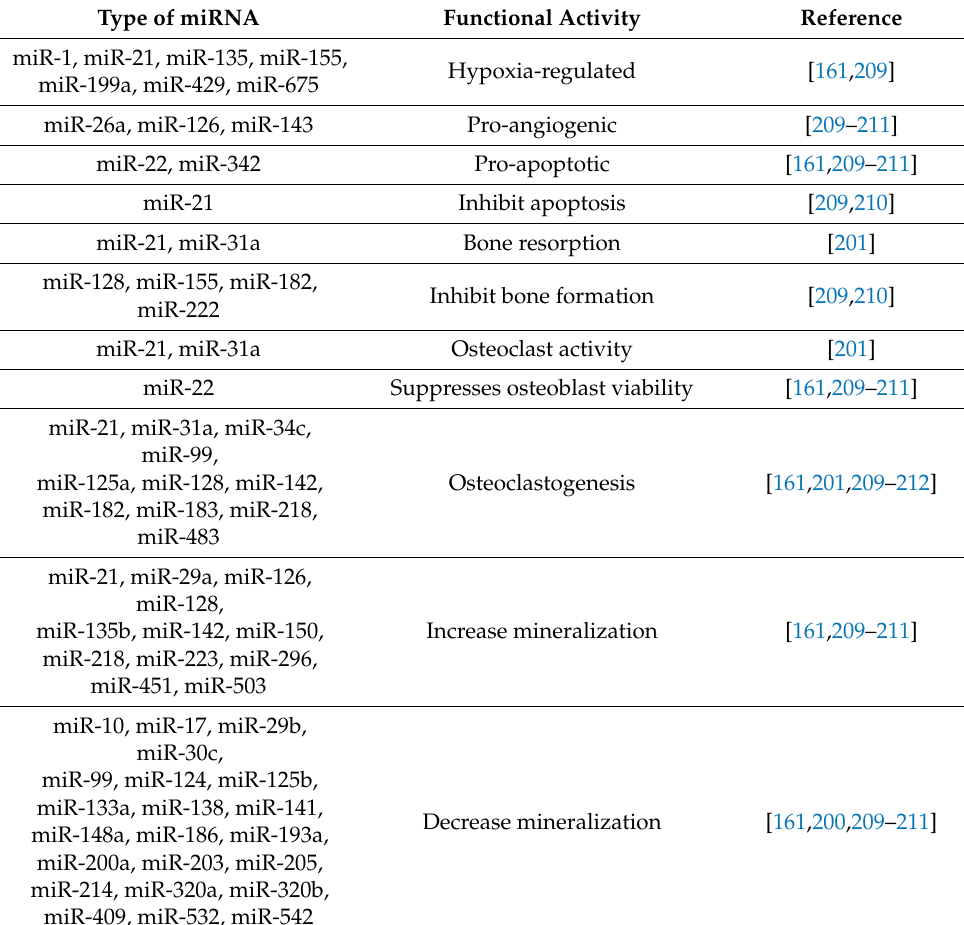
Table 4. Roles of miRNA in bone